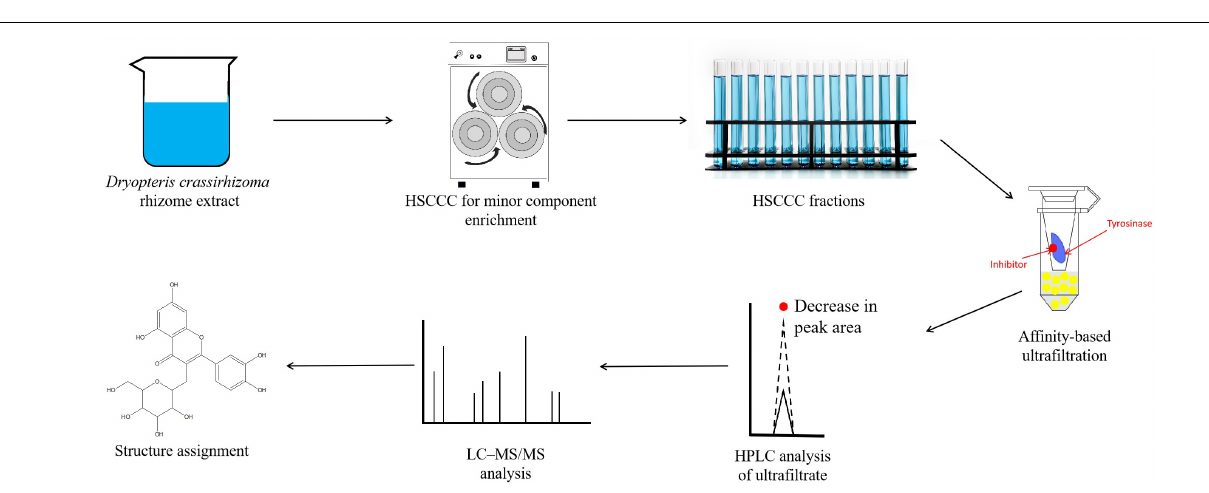
FIGURE 5 | Schematic of the hyphenated method used to identify and characterize the tyrosinase inhibiting compounds in Dryopteris crassirhizoma rhizome (DCR). Here, HSCCC, LC–MS/MS, and HPLC denote high-speed counter-current chromatography, liquid chromatography–tandem mass spectrometry, and high-performance liquid chromatography,